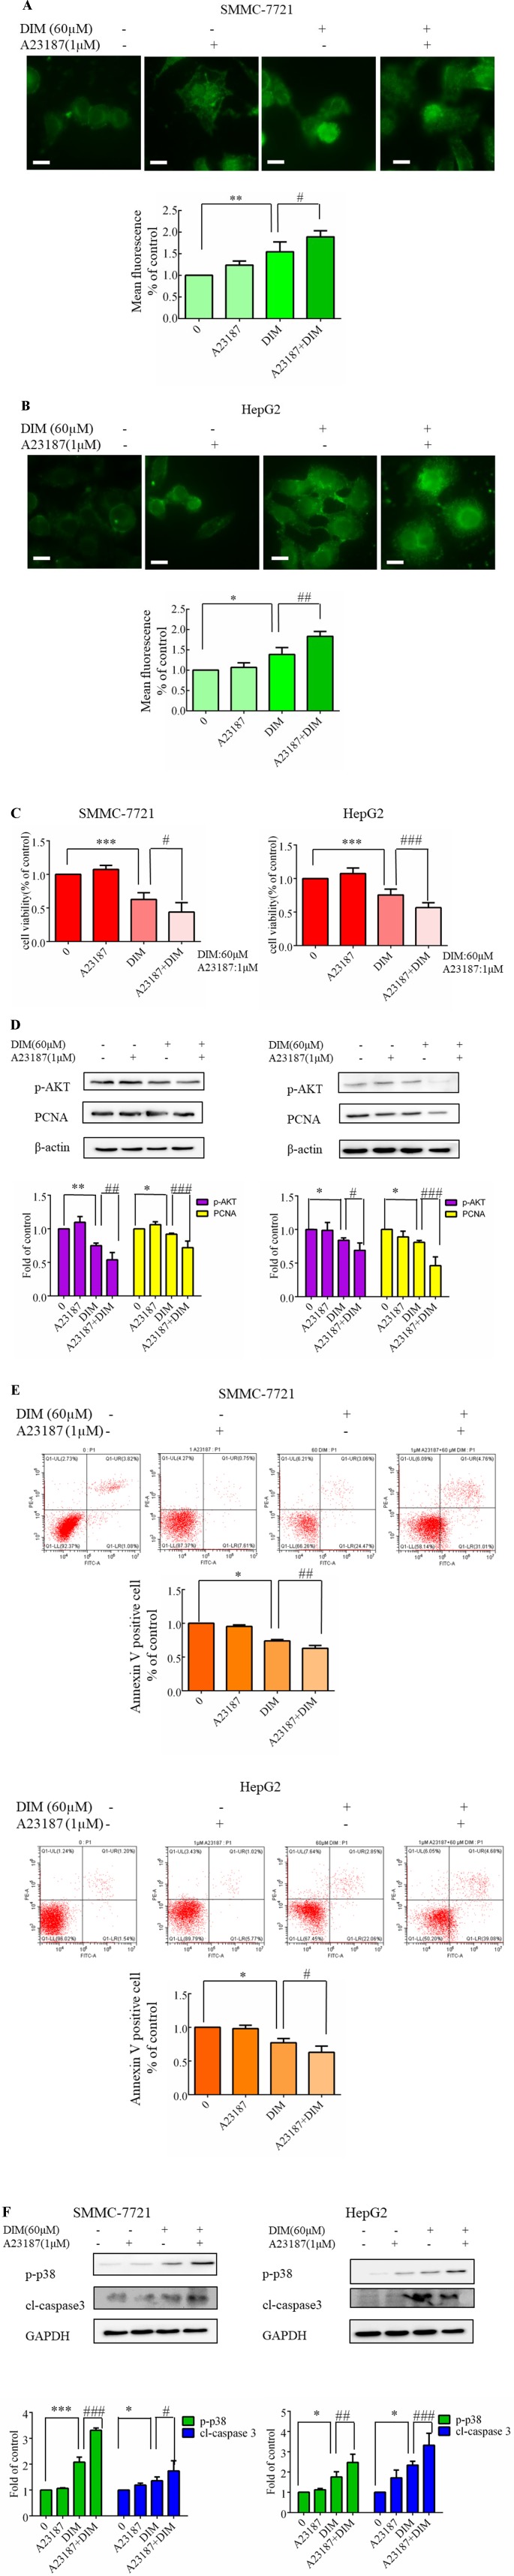
Effects of Ca2+ ionophore A23187 on DIM-induced cell apoptosis and phosphorylation of p38 MAPK in liver cancer cells. A23187 (1 µM) was added 0.5 h prior to the addition of DIM (60 µM) for 24 h in the following experiments. (A, B) Effects of A23187 on DIM-induced changes of [Ca2+]i. Analogous results were observed in a minimum of three independent experiments. (C) Effects of A23187 on DIM-induced changes of cell proliferation assessed by CCK-8 assays. Results are expressed as the percentage of blank control cells. (D) Effects of A23187 on DIM-induced changes of PCNA and p-AKT. β-actin served as a loading control. (E) Effects of A23187 on DIM-induced apoptosis detected by flow cytometry. Similar results were observed in a minimum of three independent experiments. (F) Effects of A23187 on DIM-induced apoptosis and phosphorylation of p38 MAPK. GAPDH was used as an internal control. Scale bar represents 15 µM. Data represent the mean ± SD of experiments conducted in triplicate (n = 3). *P < 0.05, **P < 0.01 and ***P < 0.001 compared with the control group, #
P < 0.05, ##
P < 0.01, ###
P < 0.001 compared with the DIM alone group.